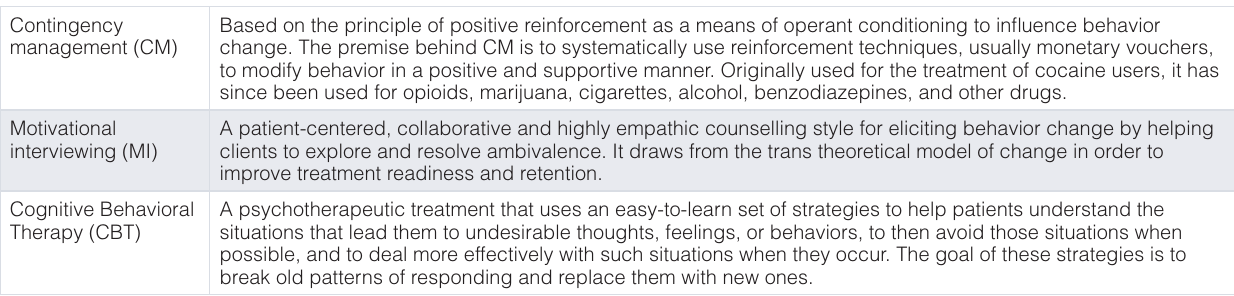
Table 1. Description of behavioral interventions for substance use